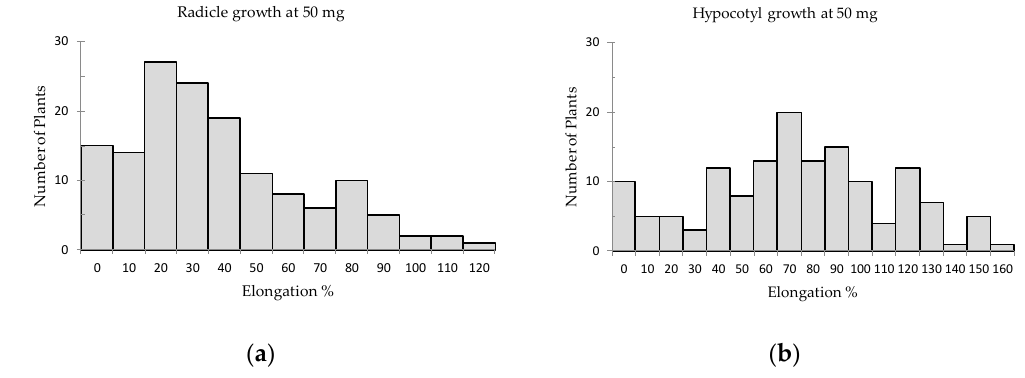
Figure 1. Effect of 10 mg screened samples on lettuce growth with the number of involved species; ( a ) Radicle elongation, ( b ) Hypocotyl elongation.